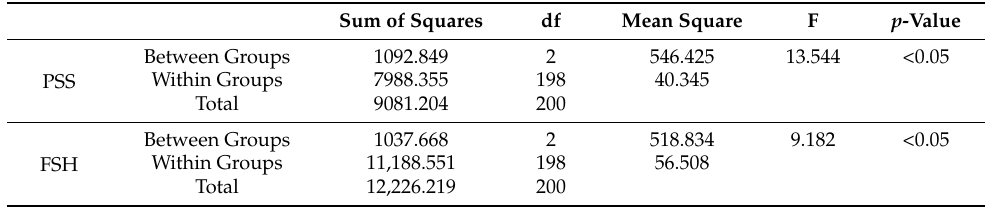
Table 5. ANOVA test output for personal safety and sexual harassment with regards to the age of the